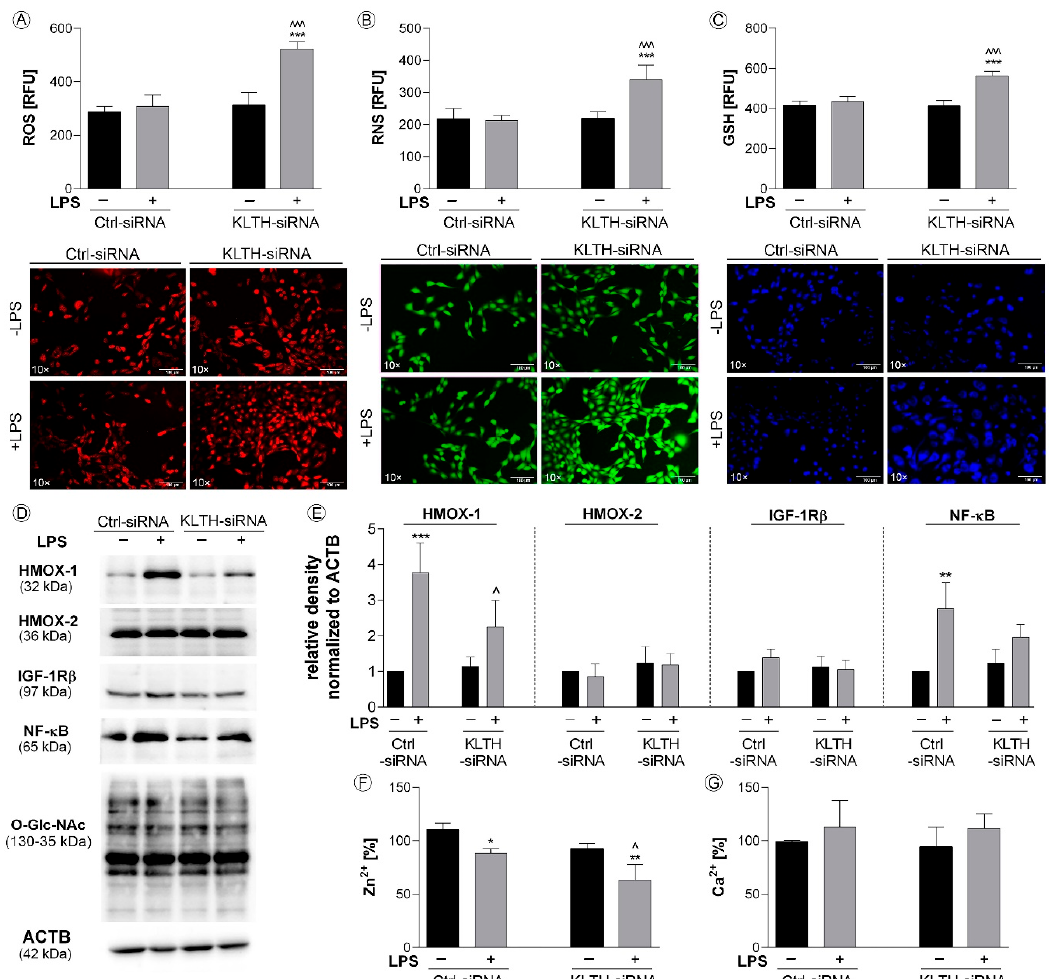
Figure 3. Klotho-depletion affects intracellular redox and mineral homeostasis. The cells were